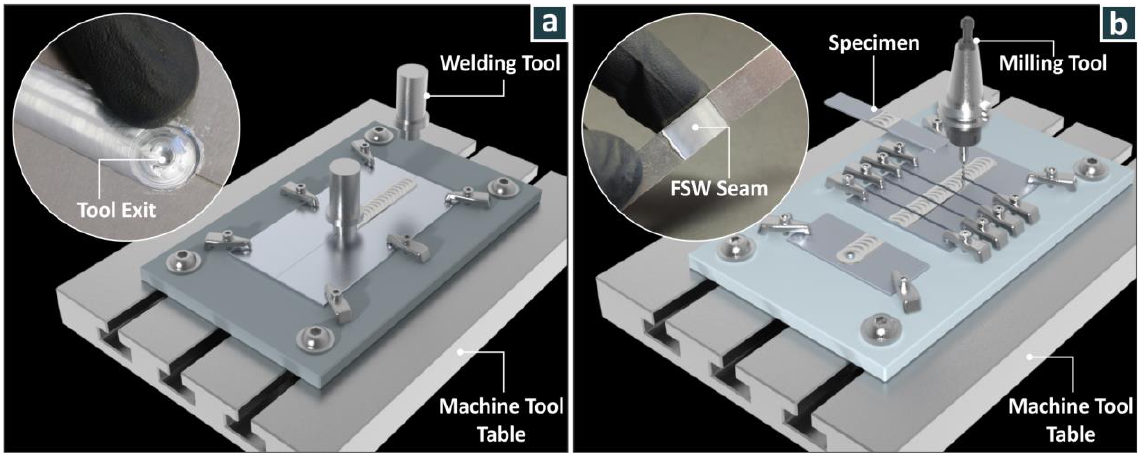
Figure 2. Experimental setup: ( a ) positioning the weld tool, ( b ) cutting the joint into tensile test specimens following welding. Table 1. Chemical composition (wt.%) of the welding tool material.